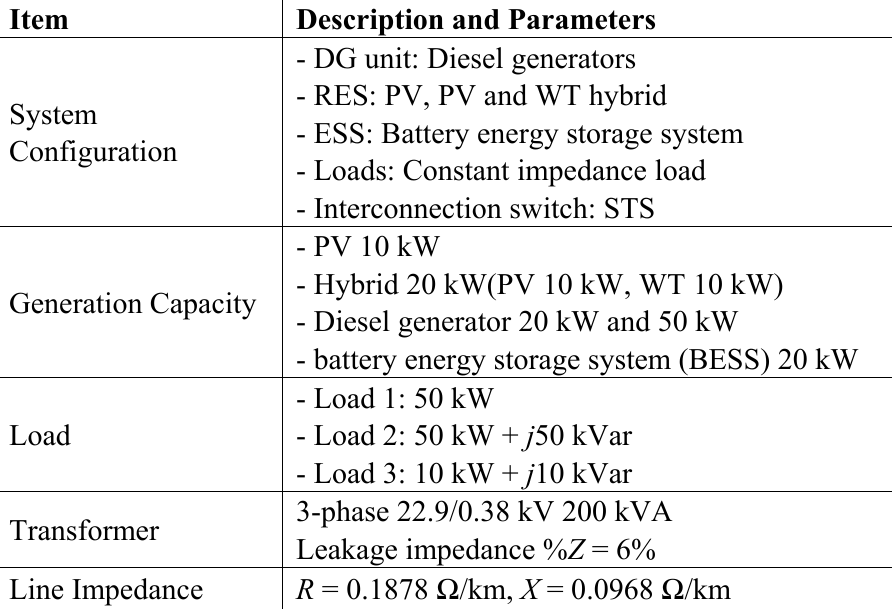
Table 2. Details of the test microgrid system.